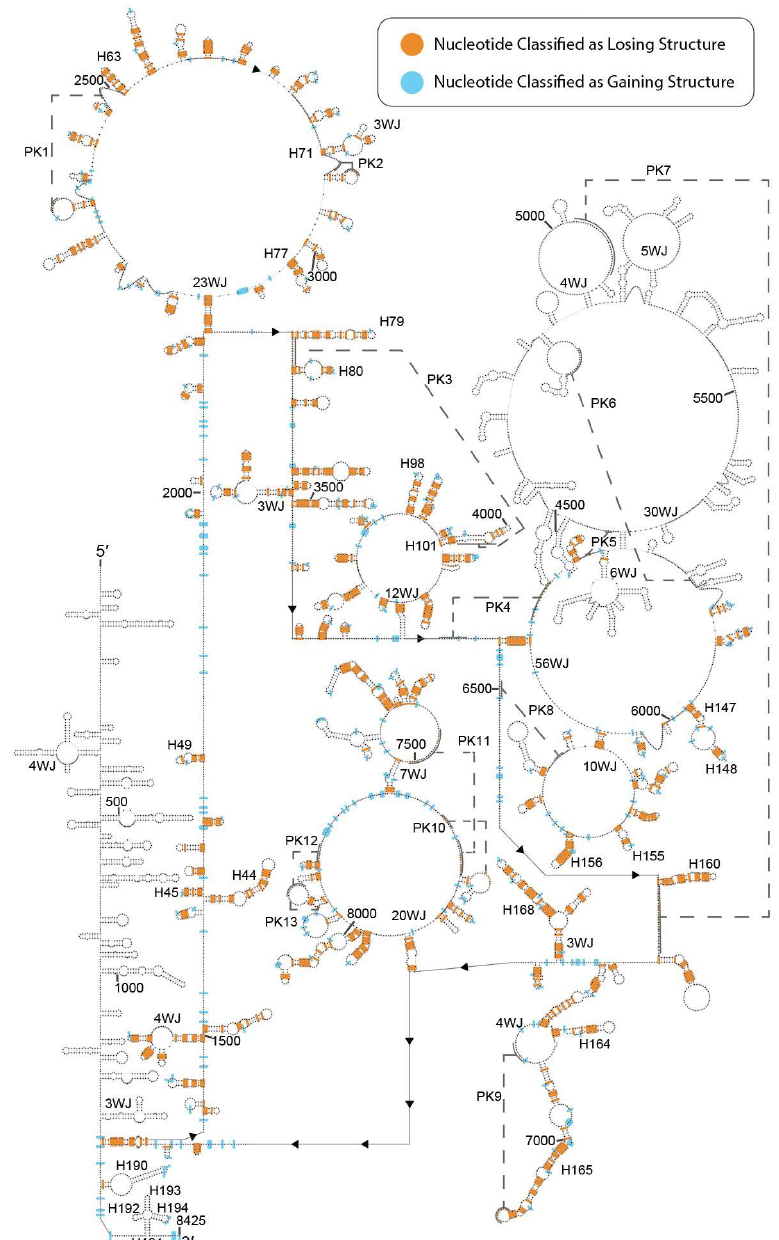
Figure 2. Map of K562 DMS-Seq structural changes onto the MALAT1 secondary structural model. K562 DMS-Seq data were available for nts 1284–4257 and nts 5839–8425. Of those indicating change in structure relative to the noncancerous consensus model, adenosine and cytidine residues that are predicted to lose structure are depicted in orange (733 datapoints) and those residues that are predicted to gain structure are depicted in blue (317 datapoints). Orange marks in hairpins have been extended to cover both nucleotides in a given base pair, and base pairs marked as unstructured have the two nucleotides moved apart to emphasize loss of structure. Labels for secondary structures correspond to those established for the working MALAT1 model in noncancerous cells [15]. Please note that PARIS-derived hairpins appear in the consensus model, although these hairpins were not considered in the differential structural analysis of